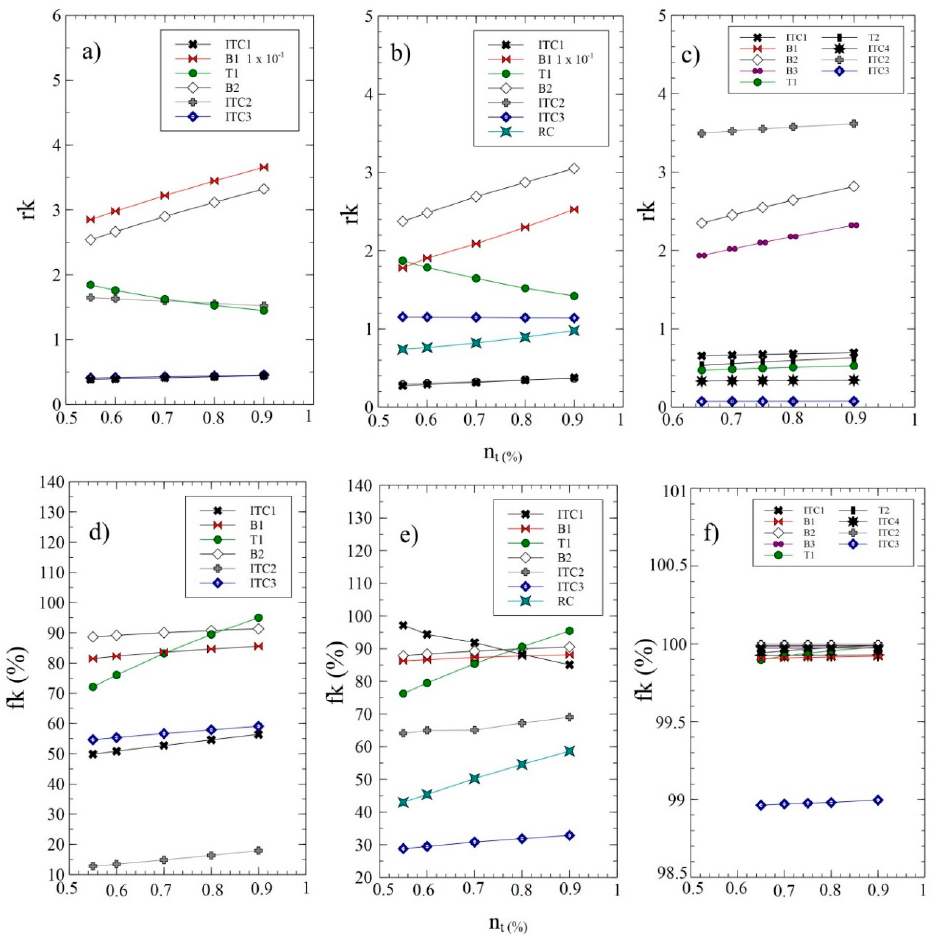
Figure 6. E ff ect of turbine e ffi ciency on relative cost di ff erence and exergoeconomic factor by component, Figure 6. Effect of turbine efficiency on relative cost difference and exergoeconomic factor by ( a – d ) SORC, ( b – e ) RORC, and ( c – f ) component, ( a – d ) SORC, ( b – e ) RORC, and ( c – f ) DORC.